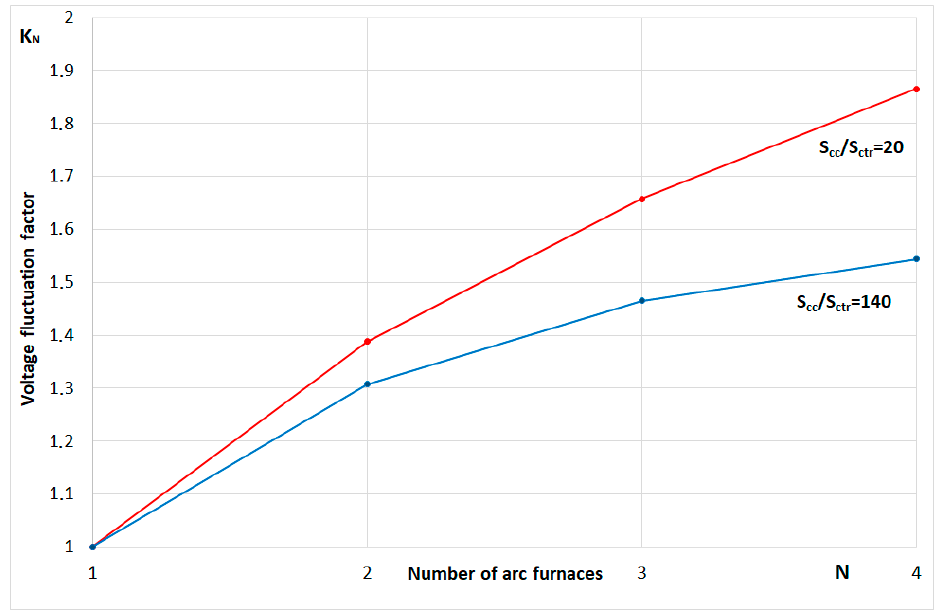
Figure 16. Change of K N versus the N number of identical arc furnaces.